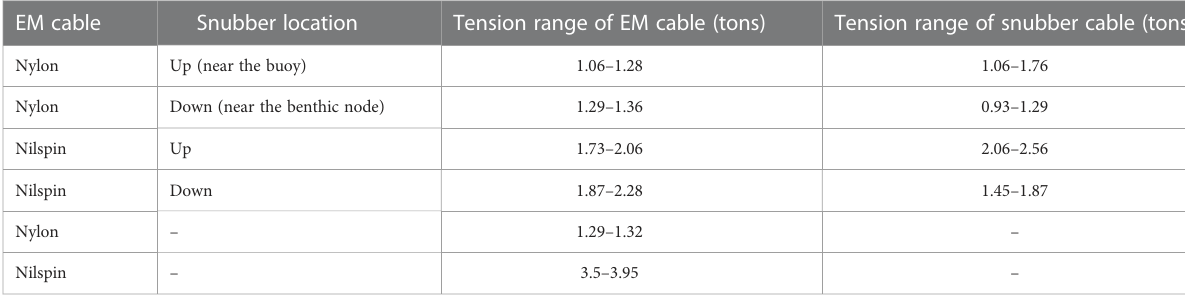
TABLE 7 Comparison of the mooring tension for different cable materials and snubber